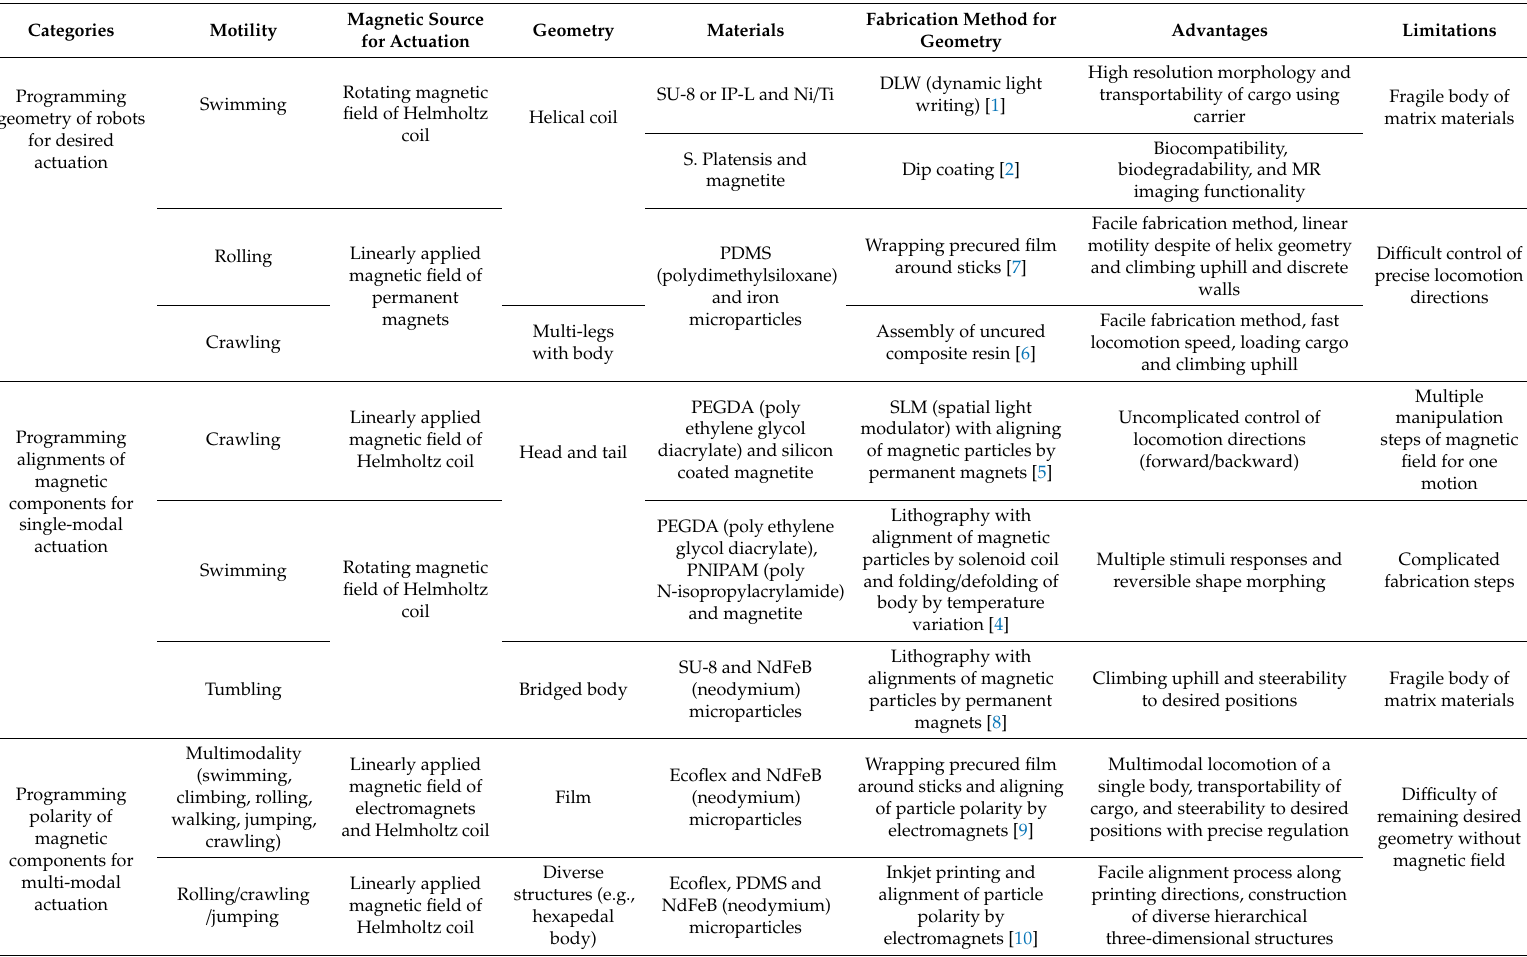
Table 1. A brief summary of magnetic soft robots including motility, external environments, magnetic source for actuation, geometry, materials, fabrication method, advantages, and